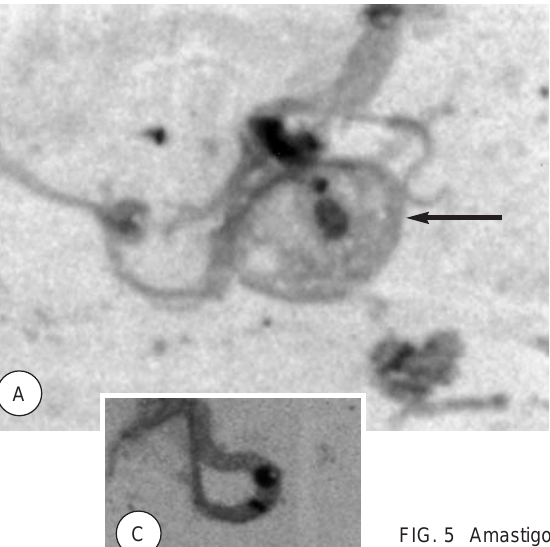
FIG. 5 Amastigote (a), epimastigote (b), trypomastigote (c) stages in haemolymph of an